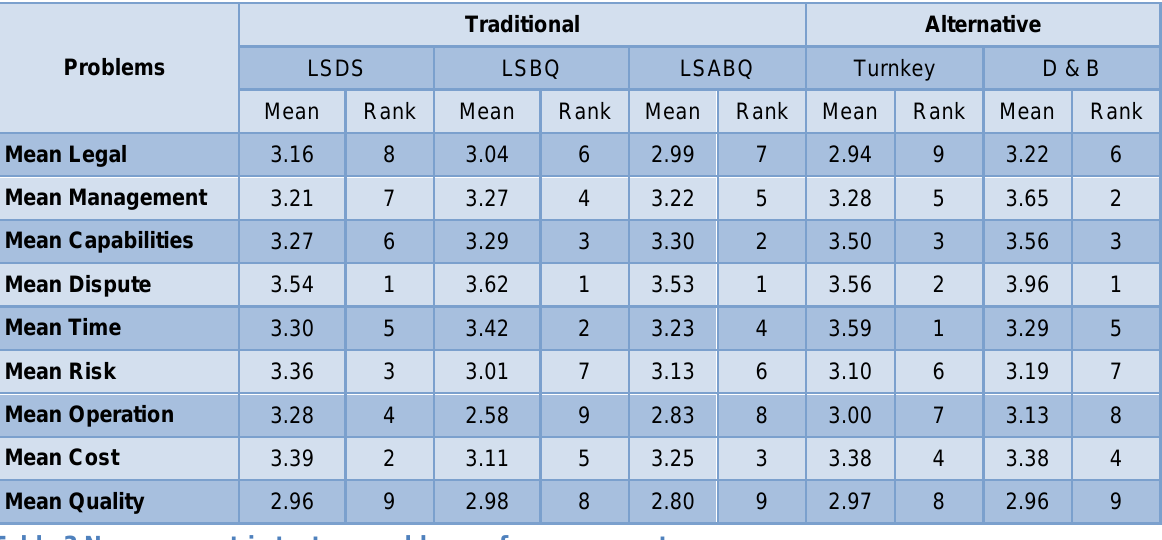
Table 3 Non-parametric test on problems of procurement Note: Less than 1.49 = strongly disagree; 1.5 – 2.49 = disagree; 2.5 – 3.49 = either agree or disagree; 3.5 – 4.49